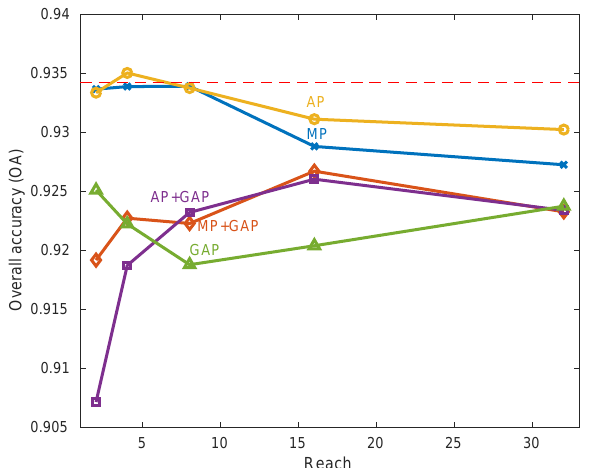
Figure 9. Overall Accuracy (OA) as function of reach for local max-pooling (MP) in blue, local max-pooling and global average pooling (MP + GAP) in orange, local average pooling (AP) in yellow, local and global average pooling (AP + GAP) in purple, and global average pooling (GAP) alone in green. We use the dataset with three spectral bands and a regular temporal sampling at two